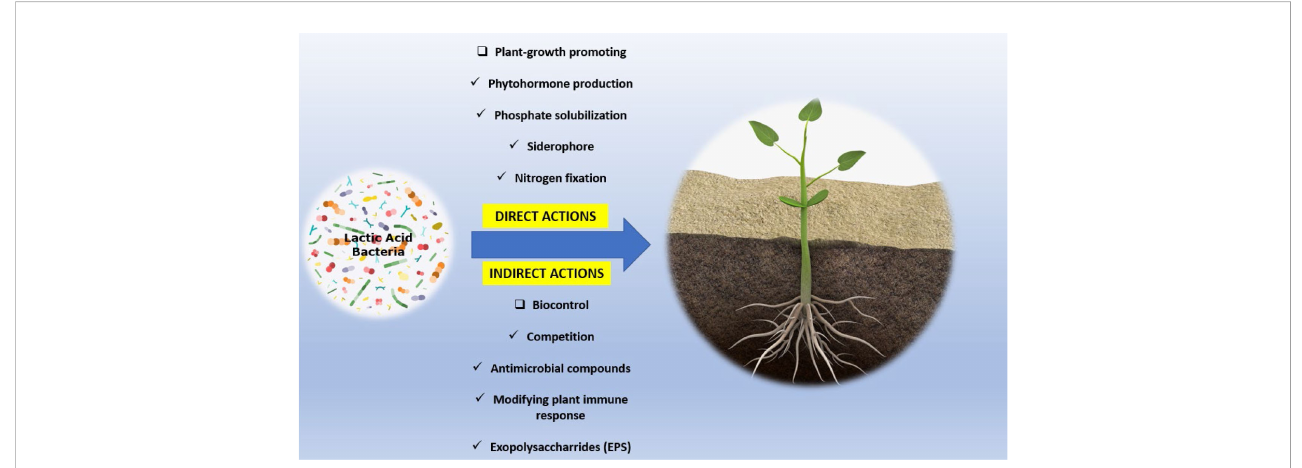
FIGURE 1 LAB mechanisms of biological control and plant-growth promoting for plant